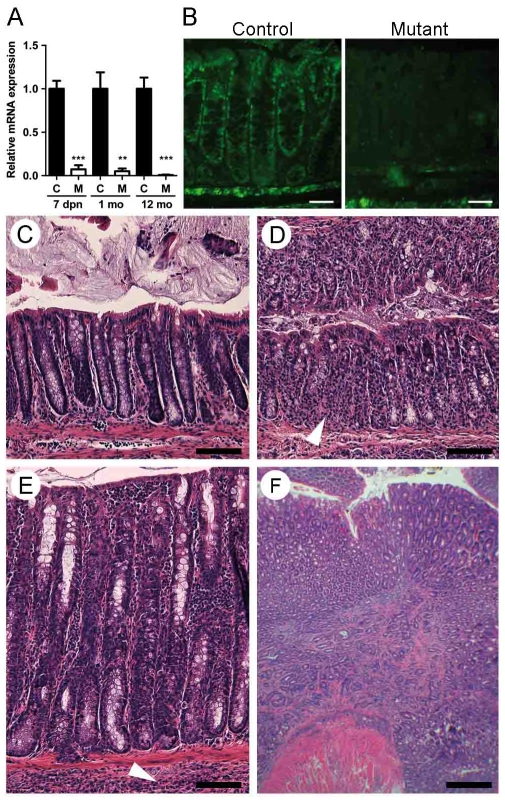
Epithelial specific loss of Hnf4α leads to various signs of chronic colon inflammation.(A) qRT-PCR of Hnf4α mRNA at 7 days, 1 month and 12 months in mutants (open bars) relative to controls (black bars). Expression levels are shown as mean values (±SEM) relative to controls for each time point (3–8 mice per group) and were normalized with the Tbp housekeeping gene. **P≤.01 and ***P≤.001. (B) Indirect immunofluorescence of Hnf4α performed on controls and Hnf4α colon null mice. A non-specific fluorescent signal was observed in the stroma of both control and null mice. Scale bars, 50 µm. (C) H&E staining of a healthy mucosa in mutants. (D) Mucosa with signs of crypt distortion and crypt loss. (E) Increased crypt length and cell infiltrates. (F) Polyp formation. These photographs are representative of eight 12 month-old individuals all showing these morphological features. The formation of polyps was only observed in 2 independent Hnf4α colon null mice. All scale bars are 100 µm except for panel F that is 200 µm.